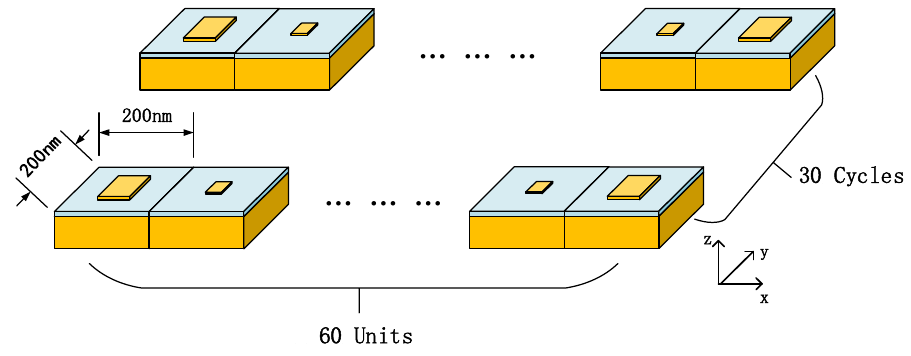
Figure 1. Diagram of the metalens structure.